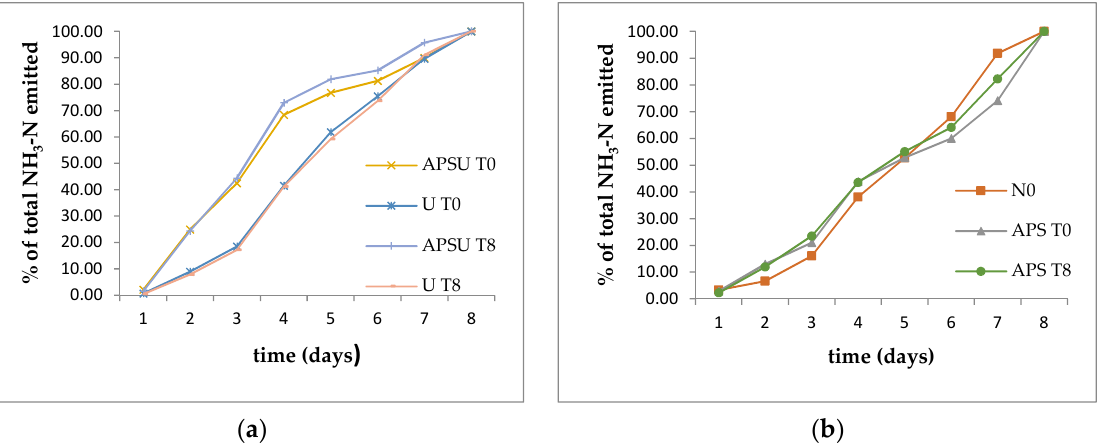
Figure 5. NH 3 -N emission dynamics (percentage of the total NH 3 -N emitted by day). ( a ) Emissions dynamics from APSU T0, APSU T8, U T0, U T8. ( b ) Emissions dynamics from APS T0, APS T8, N0. U: Urea; APS: Acidified pig slurry; APSU: U + APS; N0: Control; T0: Fertilizer applied right after sowing; T8: Fertilizer applied 8 days after sowing.